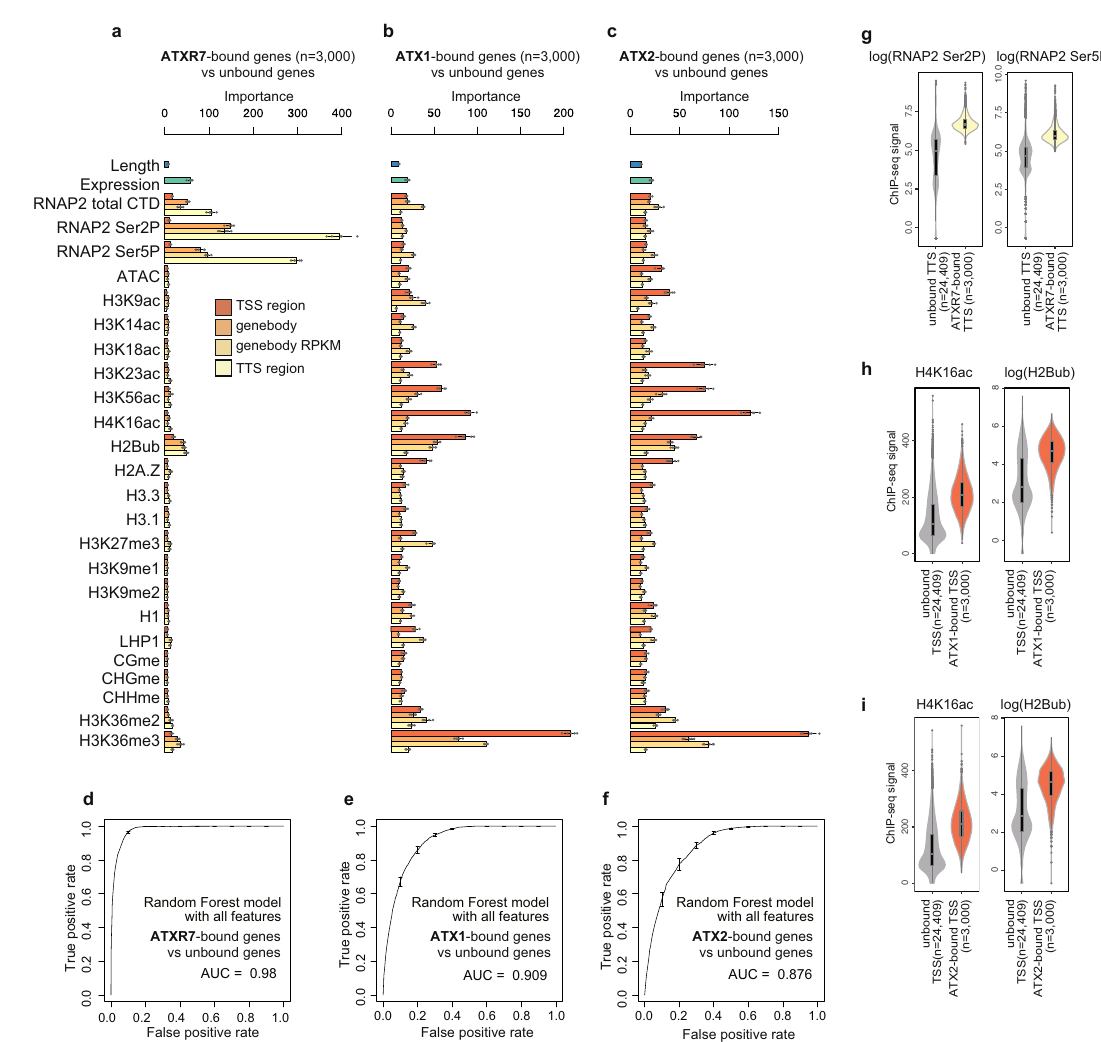
Fig. 3 | ATXR7 localization is associated with RNAP2, while ATX1 and ATX2 localization is associated with other chromatin modi fi cations. a – c Chromatin features predictive of ATXR7 ( a ), ATX1 ( b ), and ATX2 ( c ) localization. ATXR7 (or ATX1,2)-bound genes were de fi ned as the top 3000 genes with the highest ChIP-seq signal in ‘ TTS region (or TSS region) ’ compared to nontransgenic control. Random forest models were trained to predict ATXR7 (or ATX1,2)-bound and unbound genes. Bars indicate ‘ mean decrease in Gini ’ or in other words ‘ importance ’ derived from the random forest model, which is a relative score re fl ecting how informative the feature was for classi- fi cation. ‘ Importance ’ are averaged from 5 repeats of training, each of which